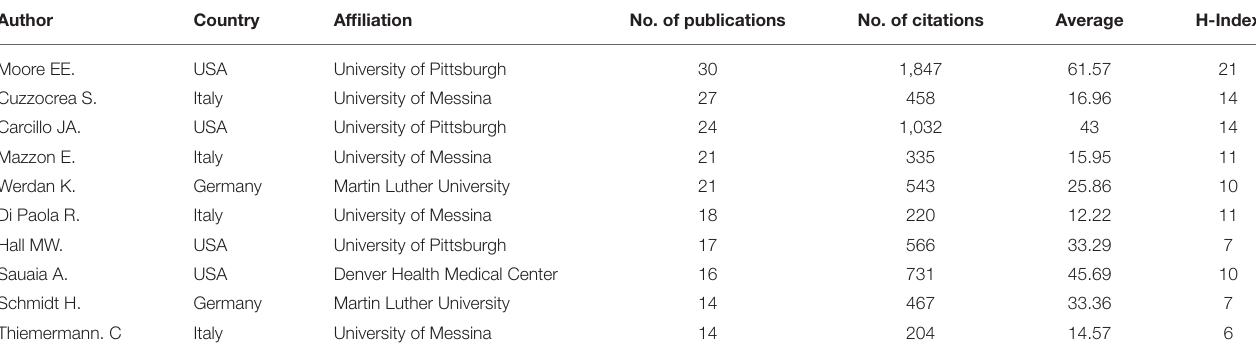
TABLE 2 | Top 10 authors with most publications in research scope of